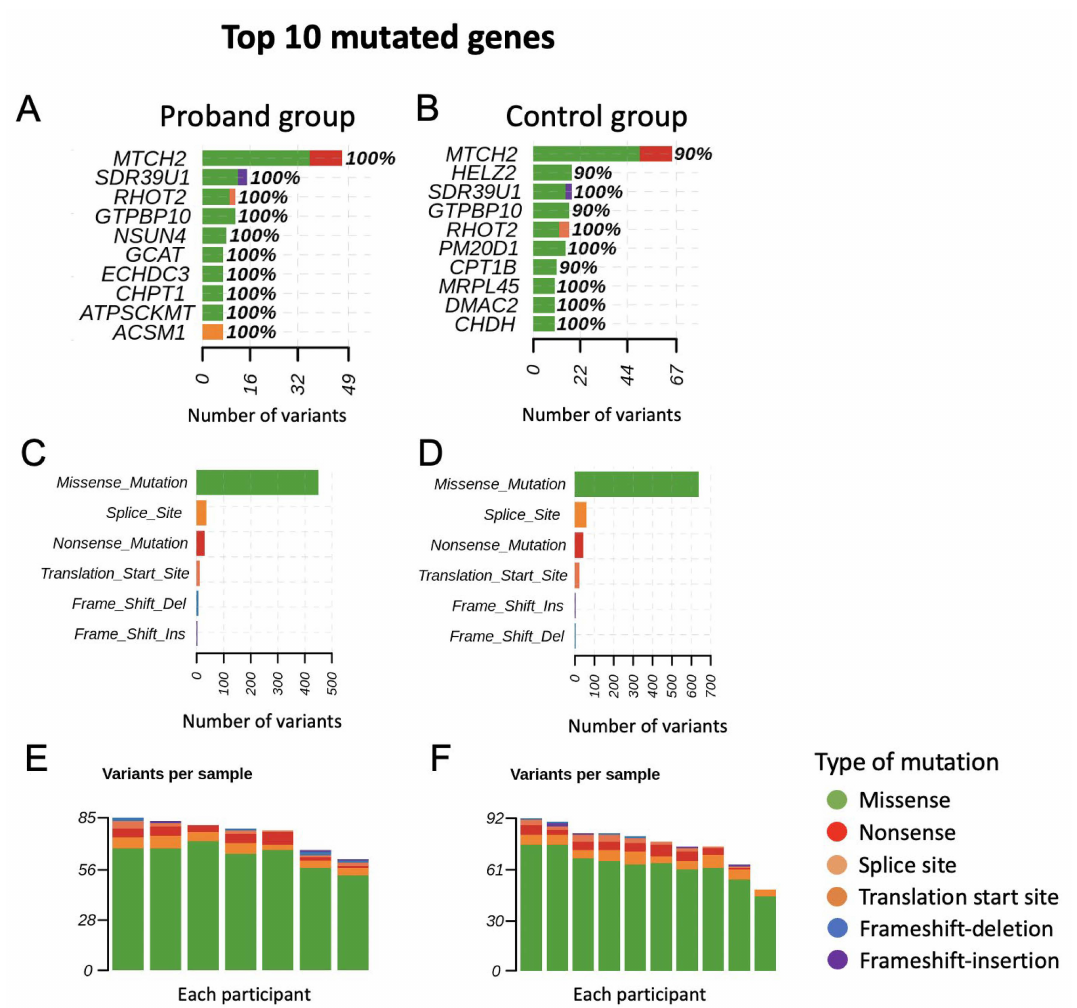
Figure 2. Mitochondria-related nuclear genes with variants in the proband and control group. The top 10 mutated genes are shown for the proband ( A ) and control group ( B ). The percentage indicates the ratio of mutation in all samples. Counts of consequences of variants for the proband ( C ) and control group ( D ). Counts of variants per sample for the proband ( E ) and control group ( F ). The color of the bars indicates the consequences of the variants while each bar presents a sample. We found that many MT genes had a high percentage of variants in either the proband group or control group, with missense mutation as the major mutation type. Forty percent of the top 10 mutated genes in the control group were the same as in the proband group, which may be related to a similar genetic background, since our controls were the proband’s relatives. The colors green, red, orange, international orange, sky blue, and violet indicate the missense, nonsense, splice site, translation start site, frameshift deletion, and frameshift insertion,